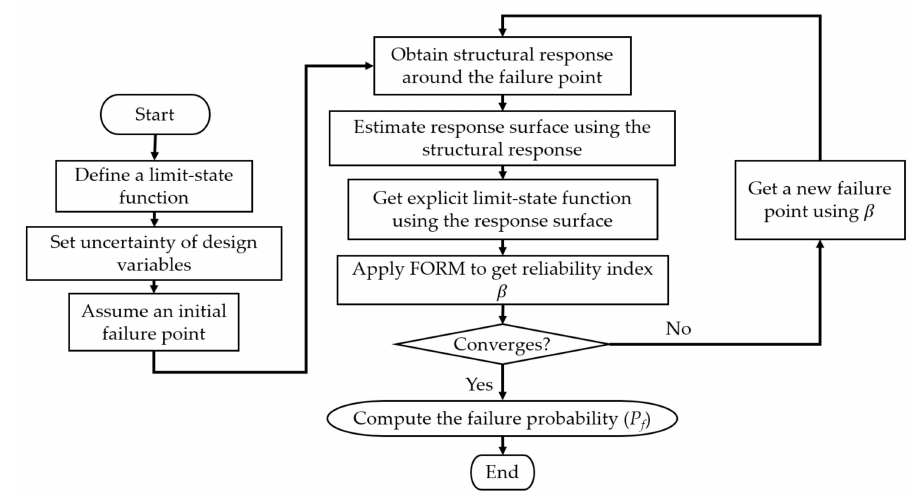
Figure 10. Flowchart for reliability analysis of an unloading arm. Table 9. Reliability index results of structural components.